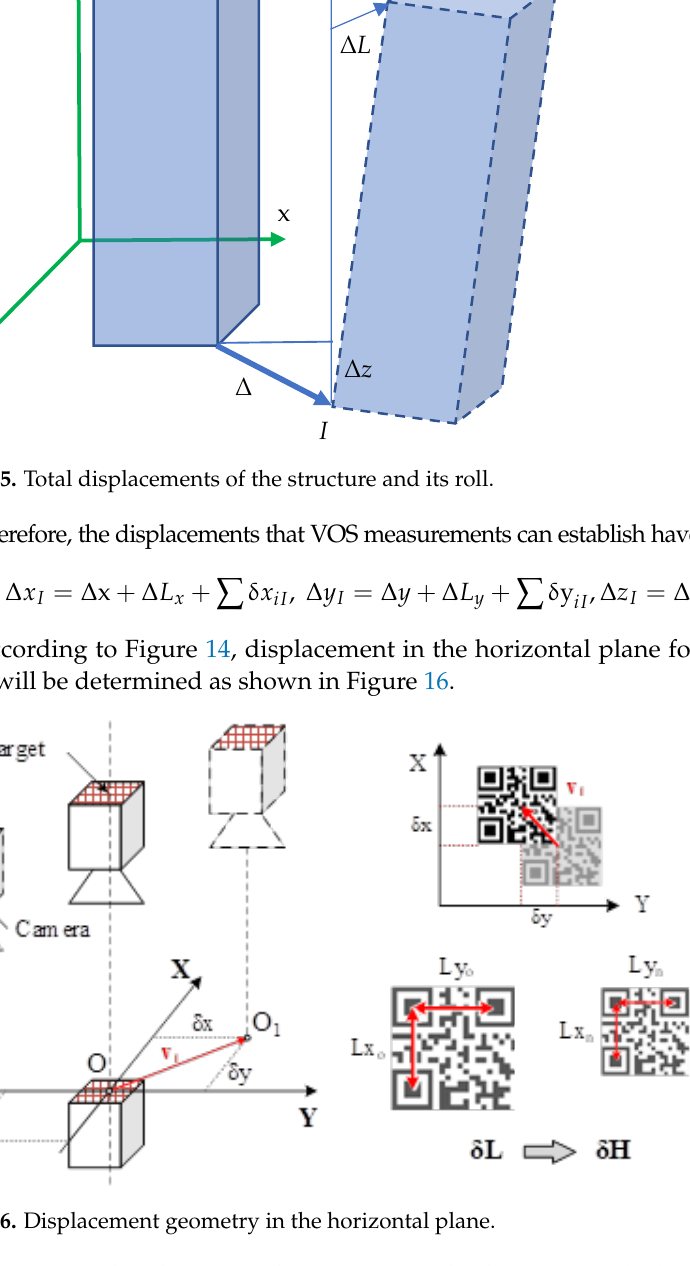
Figure 14. Displacements along vertical chains and monitoring parameters (top view) in the hori- zontal plane.